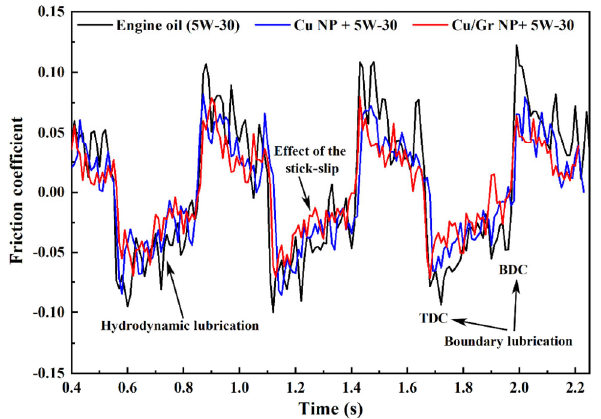
Fig. 5 Time history curves come from the friction behavior of the piston ring assembly under a contact load of 368 N and an average sliding speed of 0.25